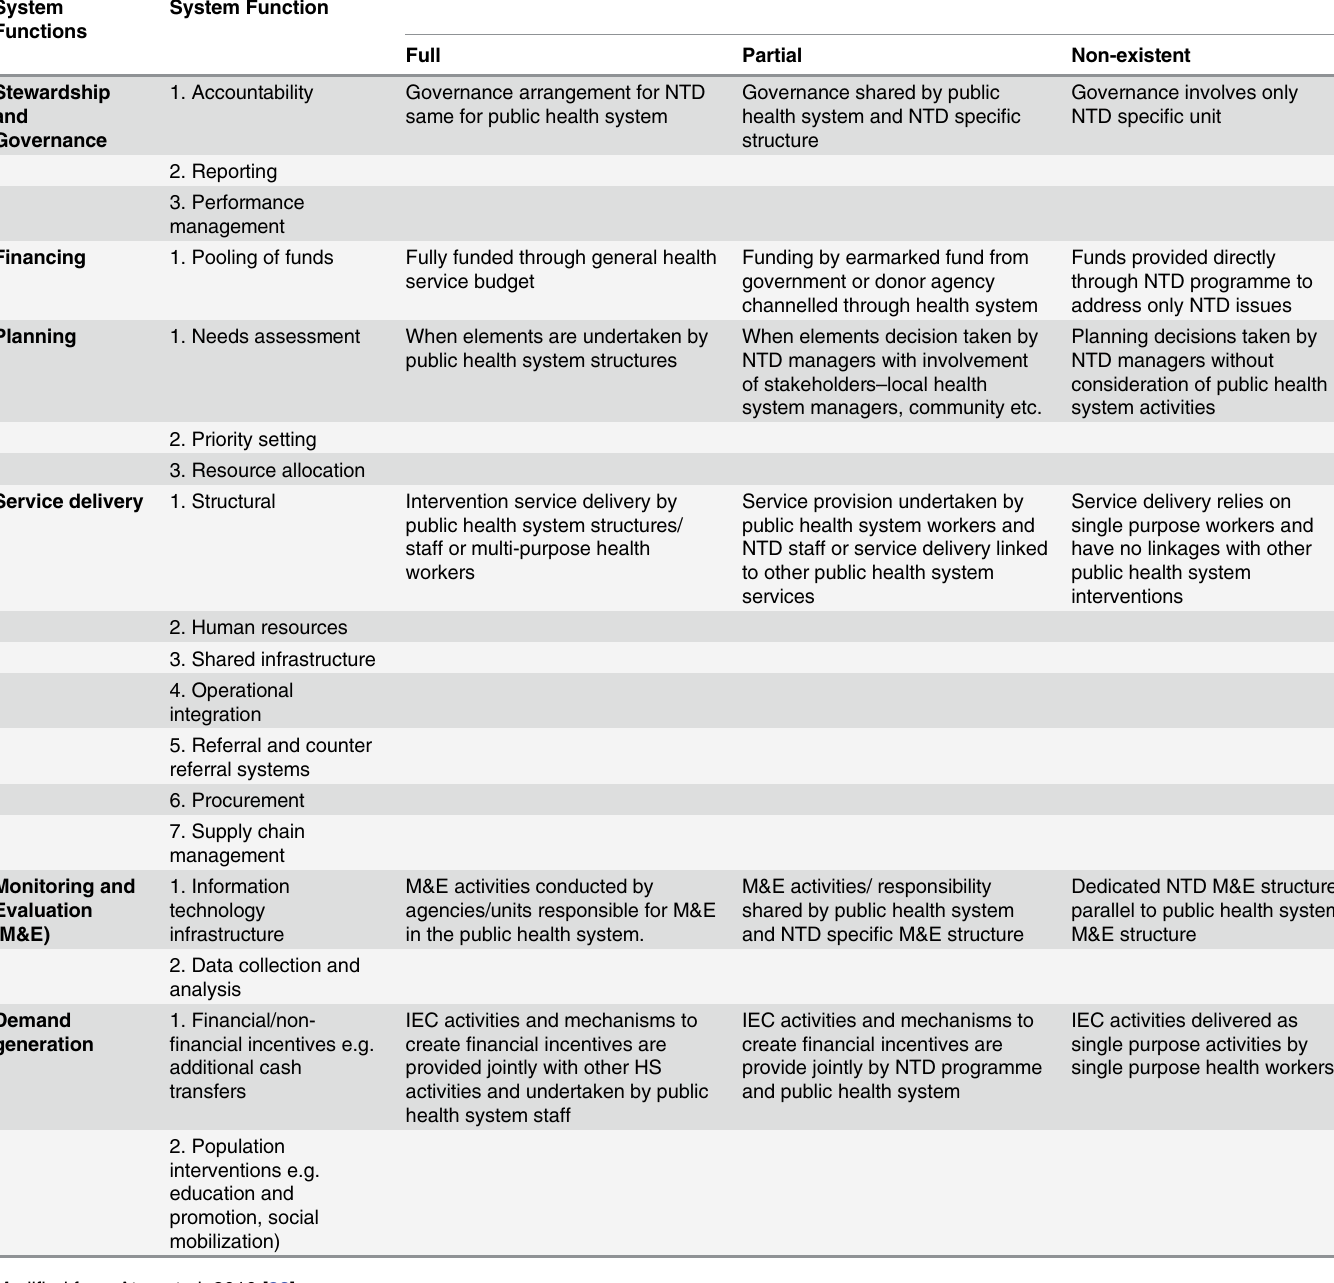
Table 1. Health system functions, elements and extent of